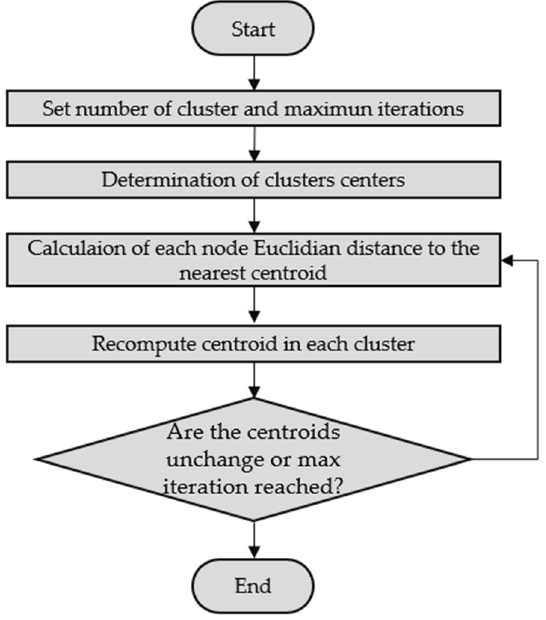
Figure 7. K-means